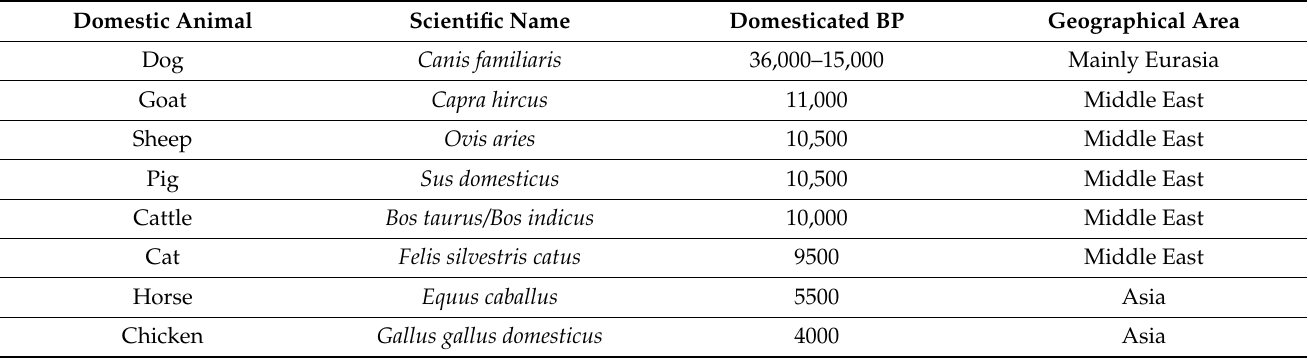
Table 2. Development of humans from hunter-gatherers to farming communities during the past 70,000 years. The domestication of animals only started during the late Mesolithic Era, and most present-day livestock species originated during the Neolithic Era. Data extracted from Zeder (2008)